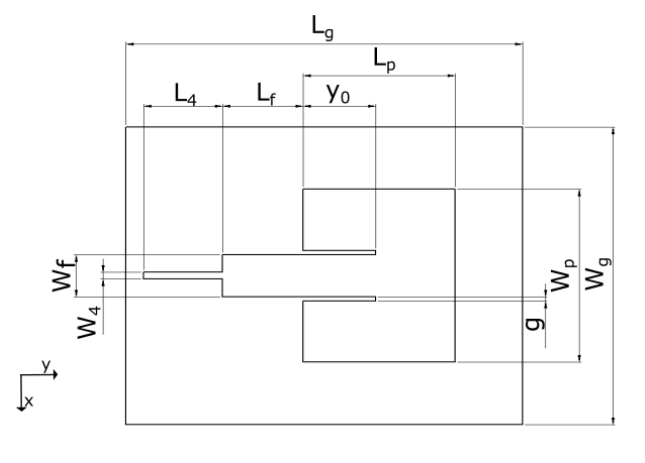
Figure 1. General layout of an inset-fed rectangular microstrip